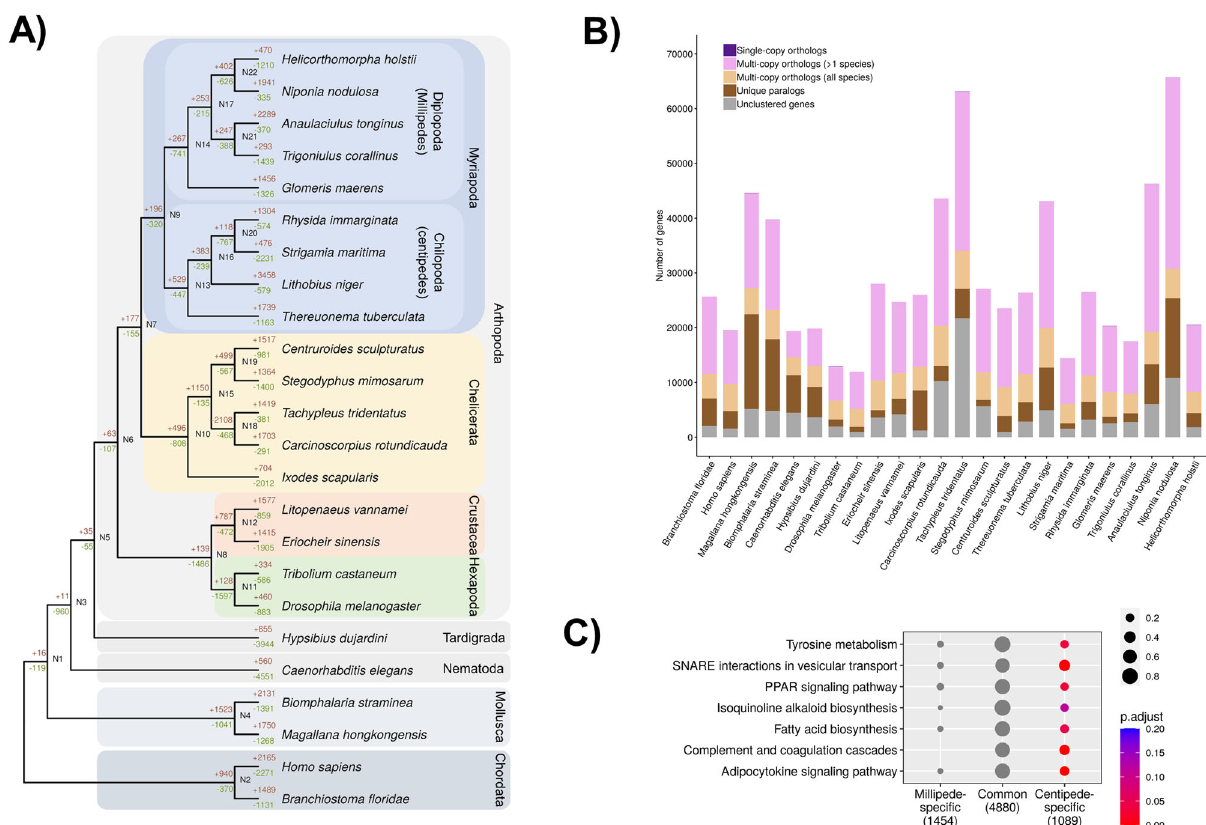
Fig. 3 Gene gain and loss in myriapod genomes. A Summary of gene gain and loss in myriapods and other reference animals. B Number of shared ortholog groups in myriapods and other reference animals. C Seven enriched KEGG pathways of gene gains in centipedes. P value is calculated based on the hypergeometric model and P value is adjusted using Benjamini and Hochberg method (BH).